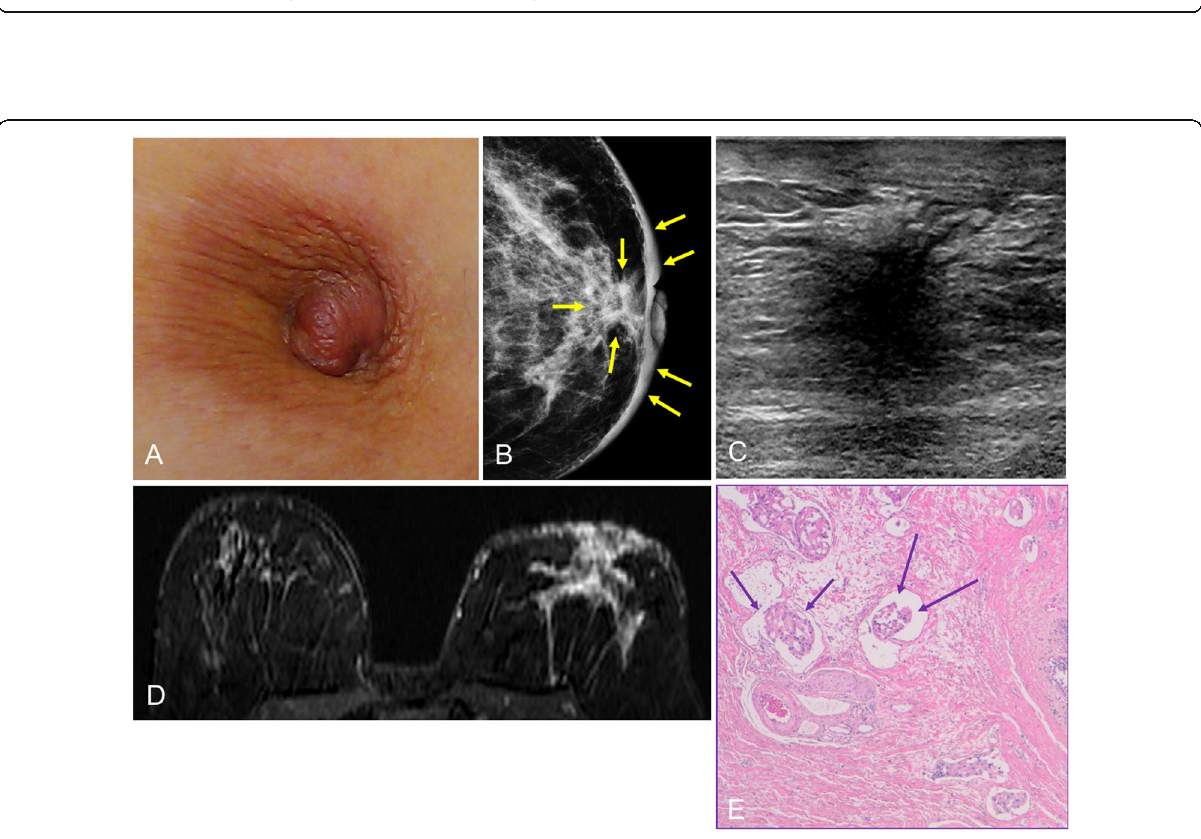
Fig. 36 Invasive ductal carcinoma (II). a Photograph of a 54-year-old woman with left nipple retraction. b Mammogram shows skin thickening and increased retroareolar density; c on ultrasound, the lesion is hypoechogenic and ill-defined. d MRI shows a large lesion in the left breast involving the nipple-areolar complex. e Hematoxylin-eosin stain (× 4) shows lymphatic invasion of the dermis of the nipple by infiltrating ductal carcinoma